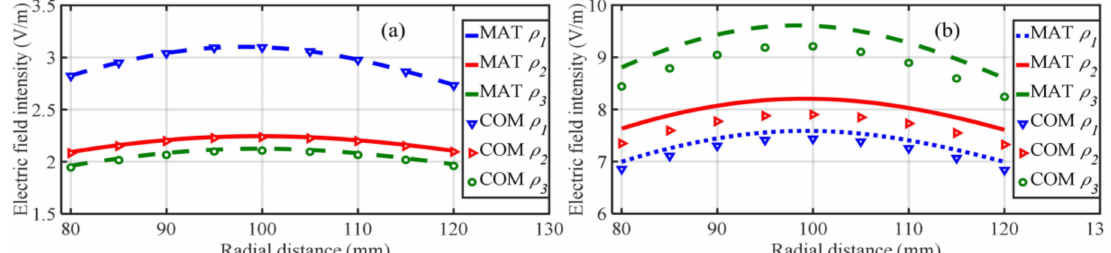
Figure 10. Analytical and simulated synthesized electric-field intensity with different N values. ( a ) is the electric field curve when the number of coil turns on both sides is 4, ( b ) is the electric field curve when the number of coil turns on both sides is